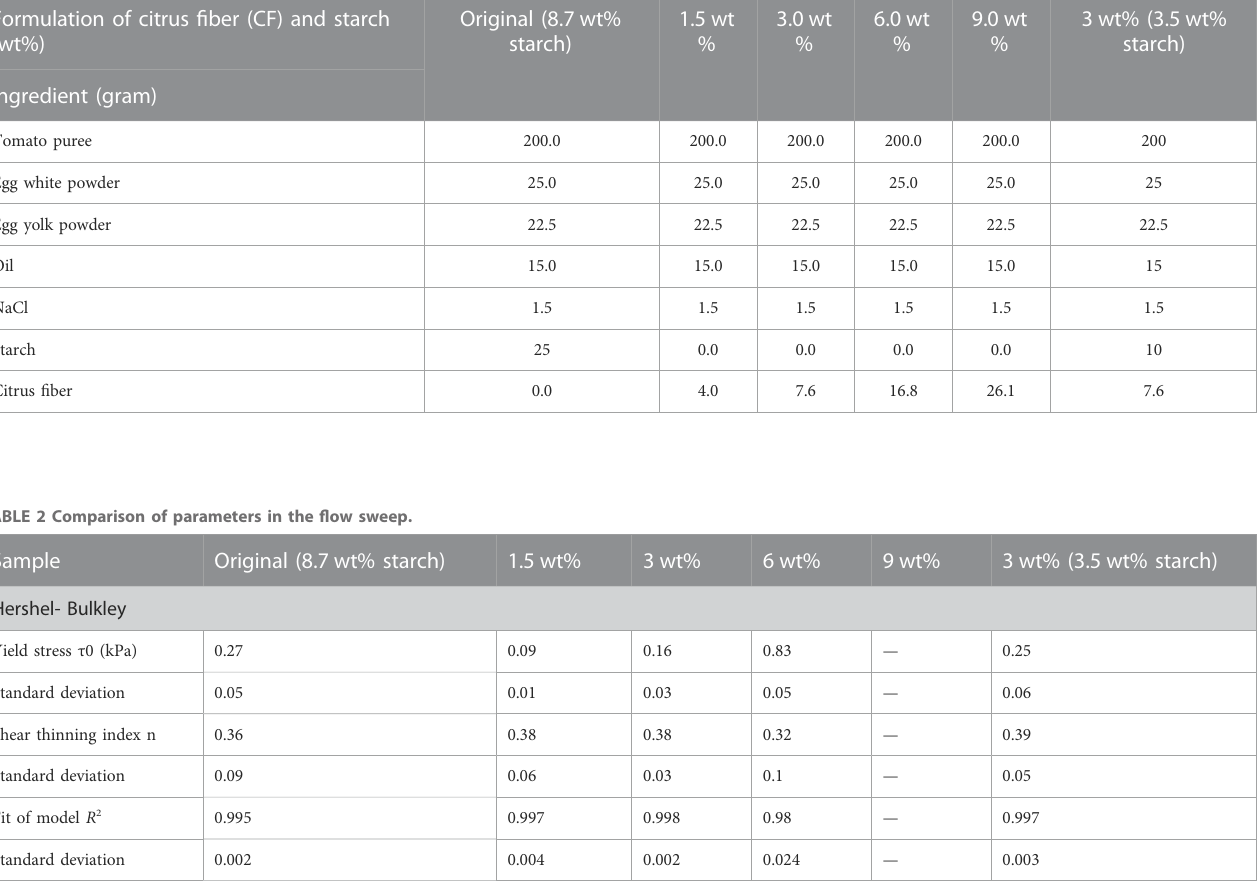
TABLE 1 Recipes of the formulations. Formulation of citrus fi ber (CF) and starch